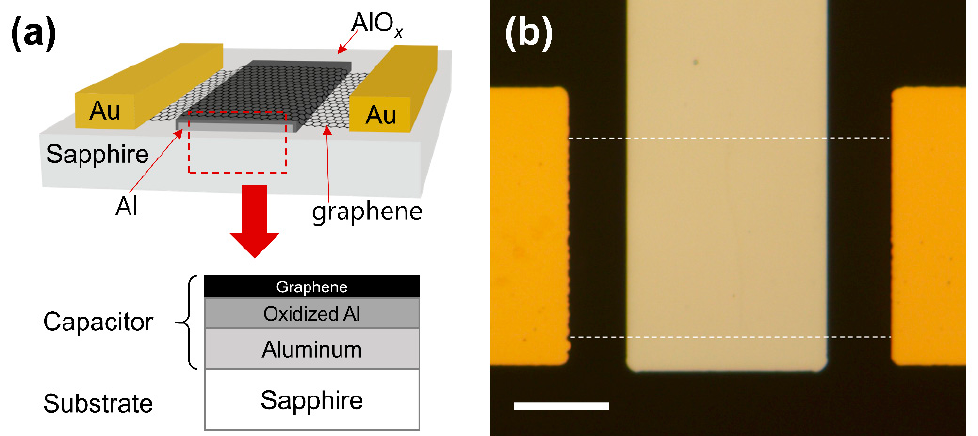
Figure 1. ( a ) Cross-sectional view of the device. The red dashed box represents the active capacitor area. ( b ) Optical microscope image of the fabricated device. The graphene channel is marked with white dashed lines. The scale bar is 15 μ m.